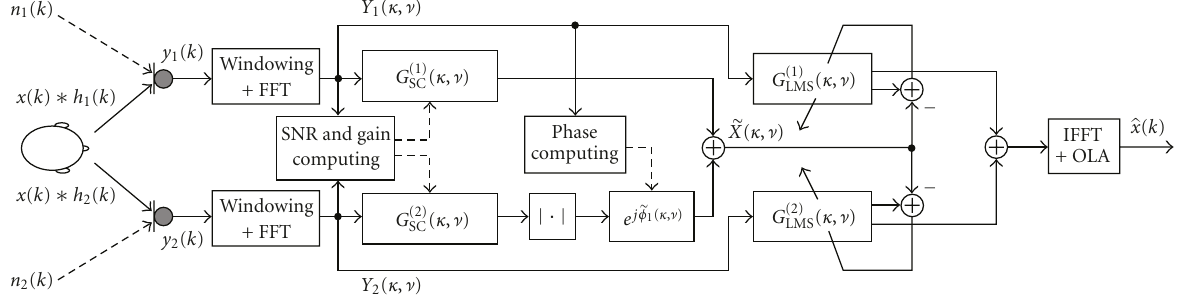
Figure 5: Basic system structure of the diversity system with two